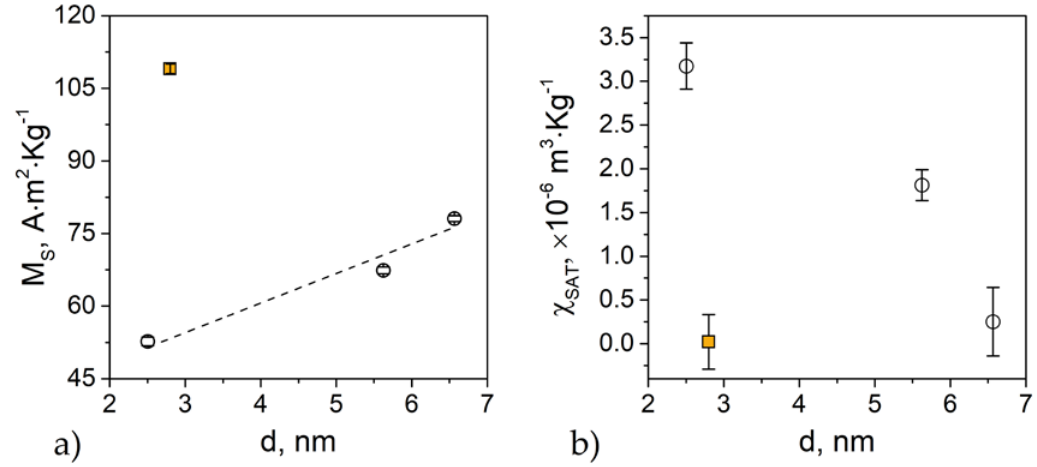
Figure 4. ( a ) Saturation magnetization, M S , and ( b ) non-saturated susceptibility, χ SAT , obtained by fitting Equation (6). The dashed line represents a guide for the eye. The square in both graphs corresponds to the reference sample N5T900.